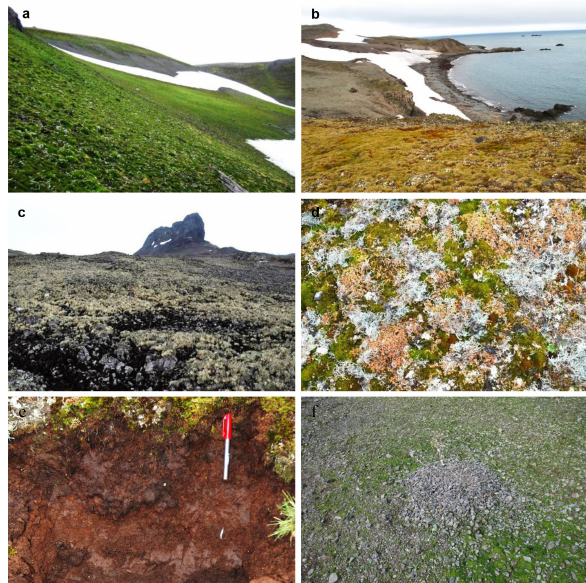
Figure 5. (a) Moss turf carpet on Stranger Point talus slope, covered with Sanionia and Polytrichales . (b) D. antarctica grass tuft around giant petrel nests in Petrel Rock. (c) Cryoplanation surface covered with fruticulose lichens Usnea sp. and Himantormia on skeletic soils. (d) Plant communities of mixed fruticulose lichens and San- ionia moss tufts in ornithogenic soils (P15). (e) P17 (Histic Leptic Cryosols (Ornithic, Arenic)) formed by humus cumulation around giant petrel nest. (f) Prasiola crispa mat around bird nest